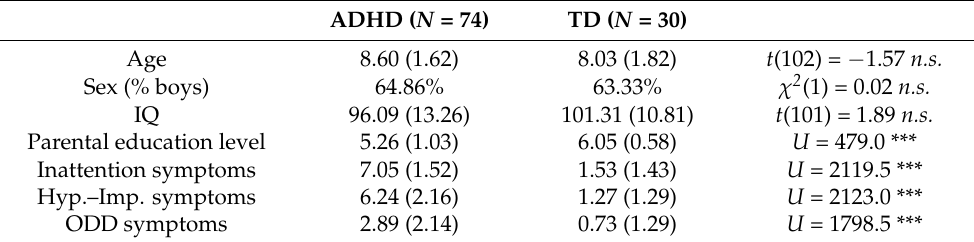
Table 1. Sample characteristics (means and standard deviations, or distribution).